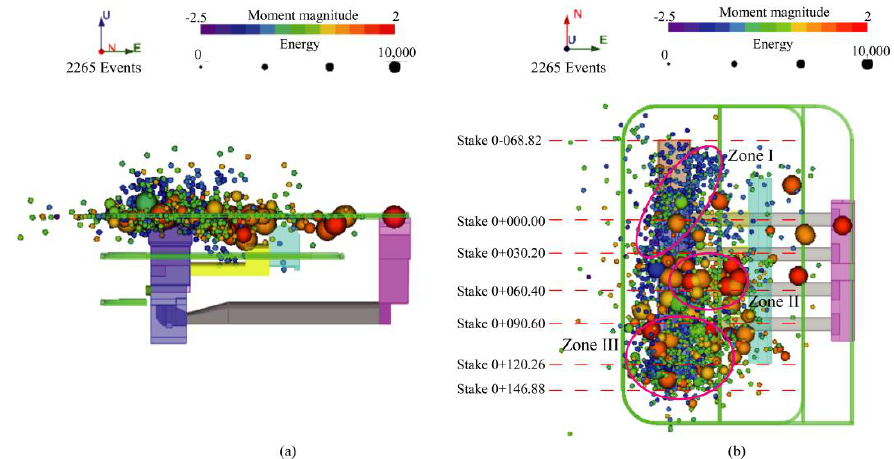
Figure 5. Spatial distribution of MS events. ( a ), Side view of MS event distribution; ( b ), Top view of MS event distribution.